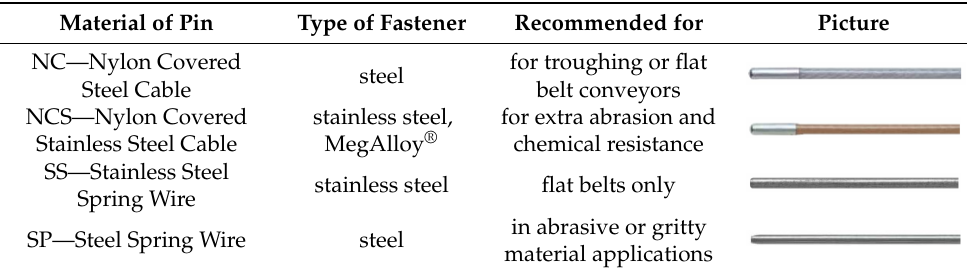
Table 2. Hinge pins various materials and different applications [25]. Material of Pin Type of Fastener Recommended for